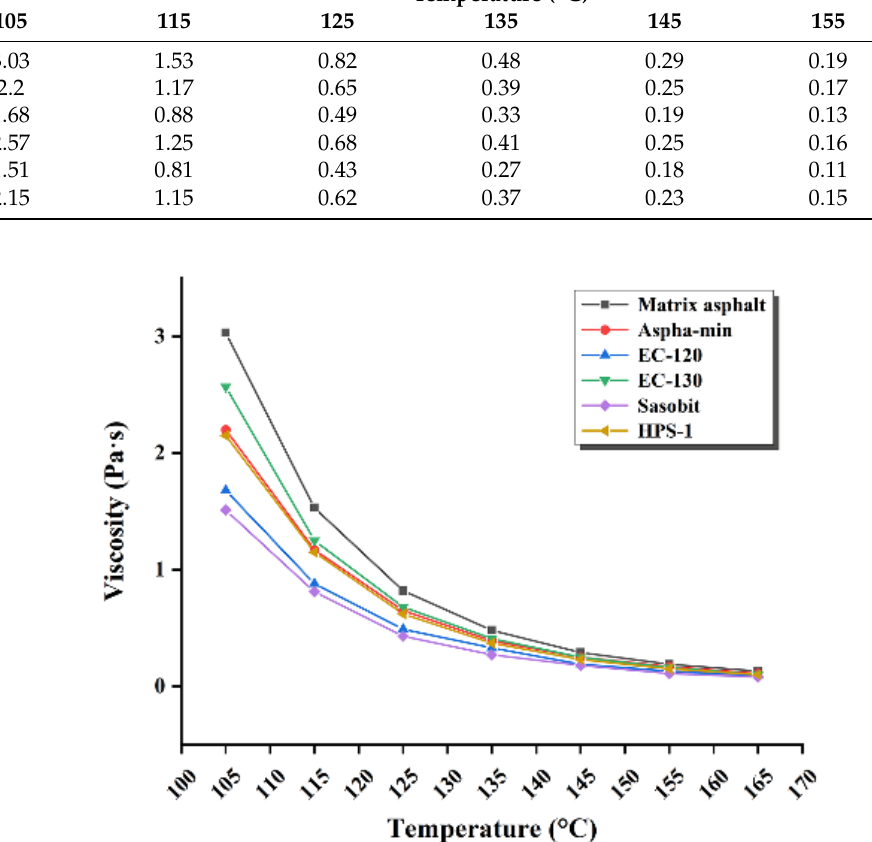
Figure 4. Viscosity of matrix asphalt and WMA at different temperatures. Table 8. Viscosity test results of different asphalts (Pa ∙ s).